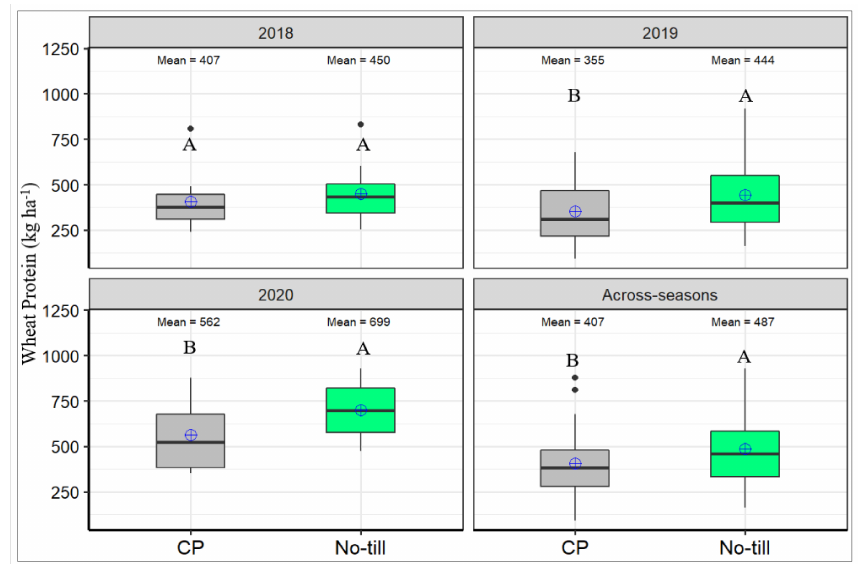
Figure 8. Protein contributions from conventional practice and NT treatments under wheat cropping system in 2018, 2019, 2020 and across the growing seasons. Means with different letters (A, B) in the same season are significantly different at p < 0.05.